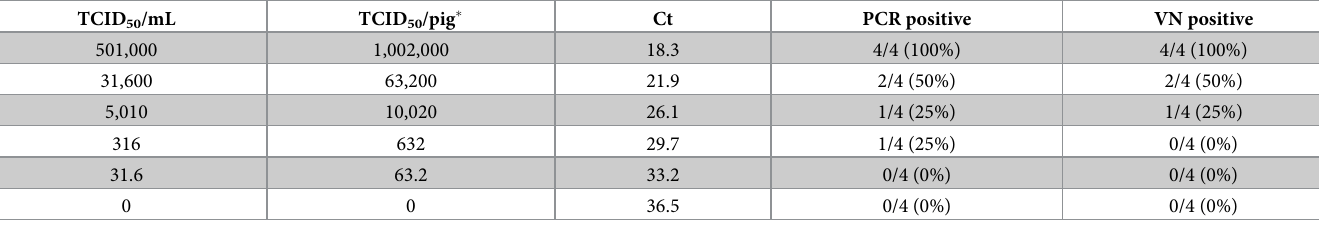
Table 6. Summary of SVA infection outcomes in neonatal pigs by PCR and VN assays. TCID 50